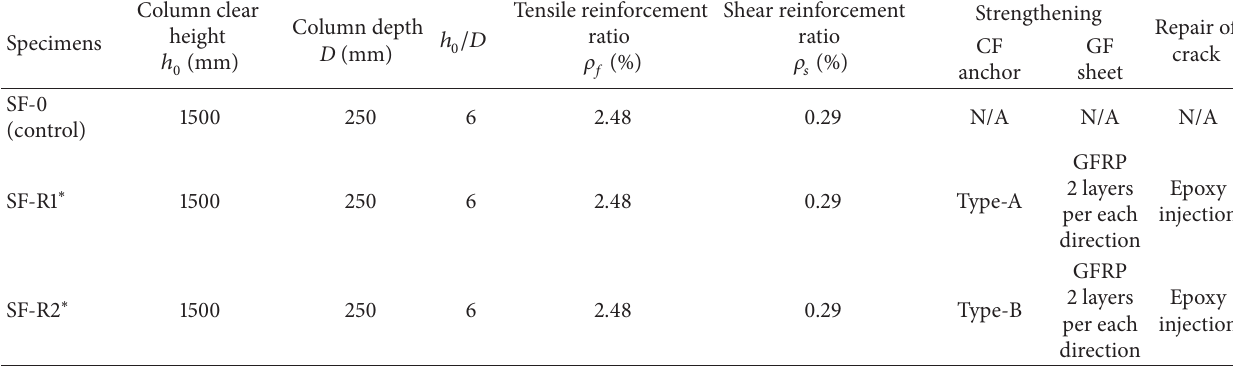
Table 6: Summary of the specimens used in this study.